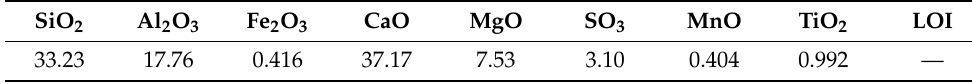
Table 2. Chemical constituents of slag powder (wt%).